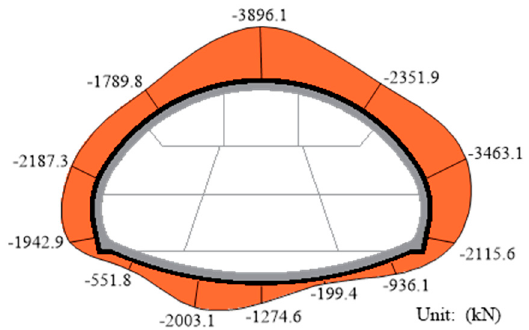
Figure 24. Final distribution of the contact pressures between the primary and secondary supports.